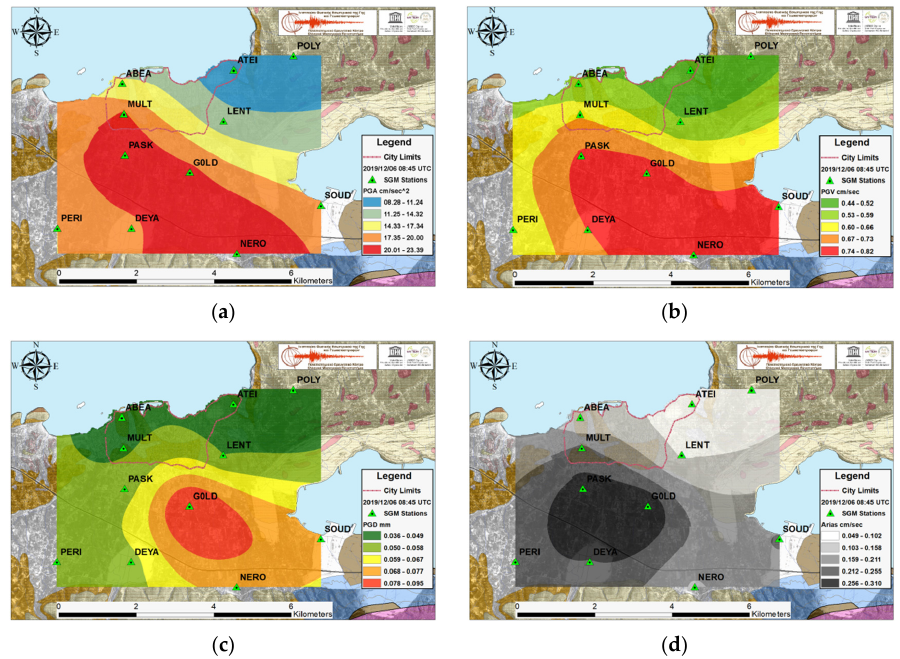
Figure 5. For the EQ.4, South of Chania, the ground motion parameter spatial distribution results obtained from Ordinary Co-Kriging: ( a ) Peak Ground Acceleration in cm/sec 2 ; ( b ) Peak Ground Velocity in cm/sec; ( c ) Peak Ground Displacement in mm and ( d ) Arias Intensity in cm/sec.